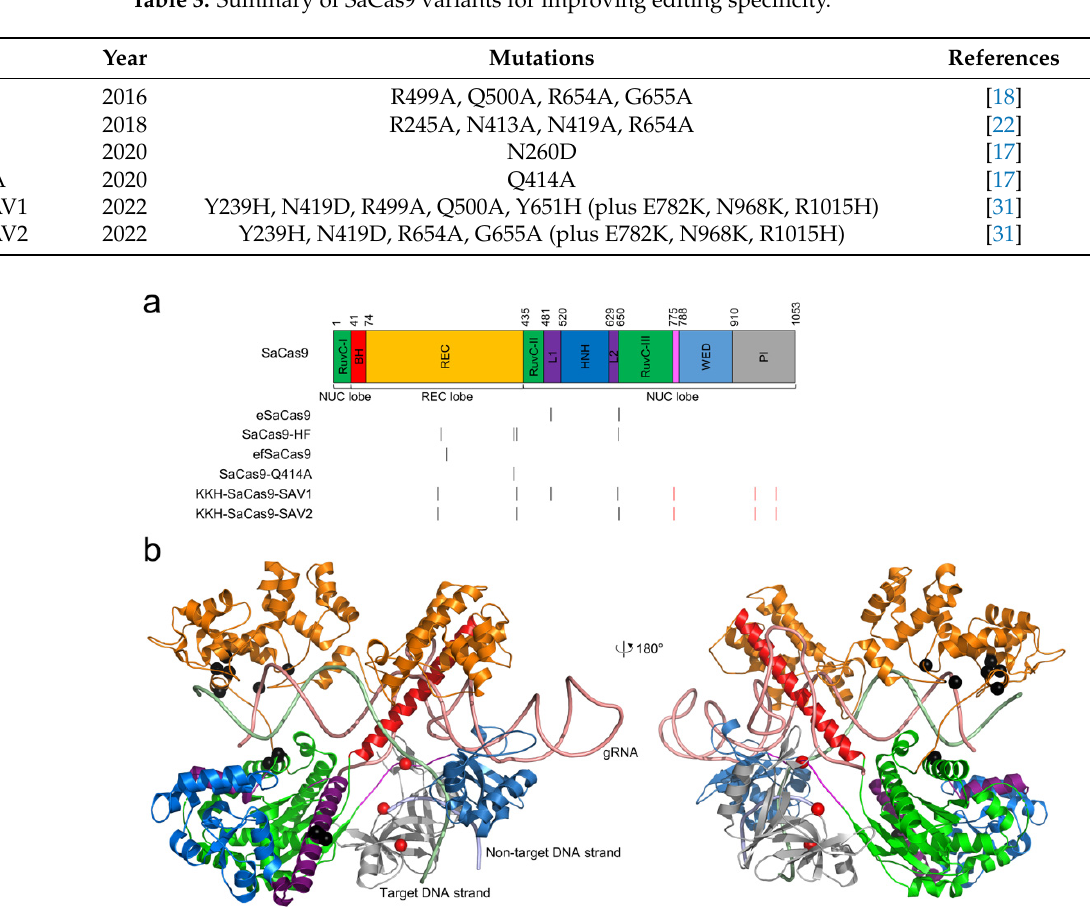
Figure 2. The locations of high-fidelity SaCas9 mutations. ( a ) domain organization of SaCas9. The architecture by Nishimasu et al. [79] is used. The positions of the mutated residues for all high-fidelity variants are indicated by black vertical lines. The PAM-relaxed KKH mutations are shown in red vertical lines. ( b ) the high-fidelity point mutations, shown as black spheres, are mapped onto the structure of SaCas9 (PDB ID: 5AXW) [79]. The KKH mutations are shown as red spheres. The color scheme for the structure is identical to that for the sequence.